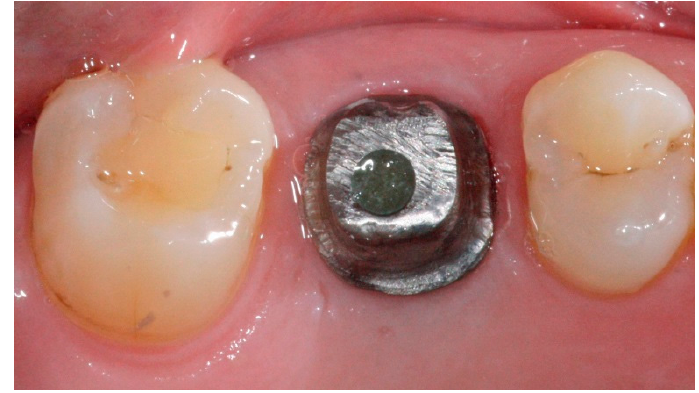
Figure 6. Titanium custom abutment in place for posterior implant restoration with anatomic emergence profile.